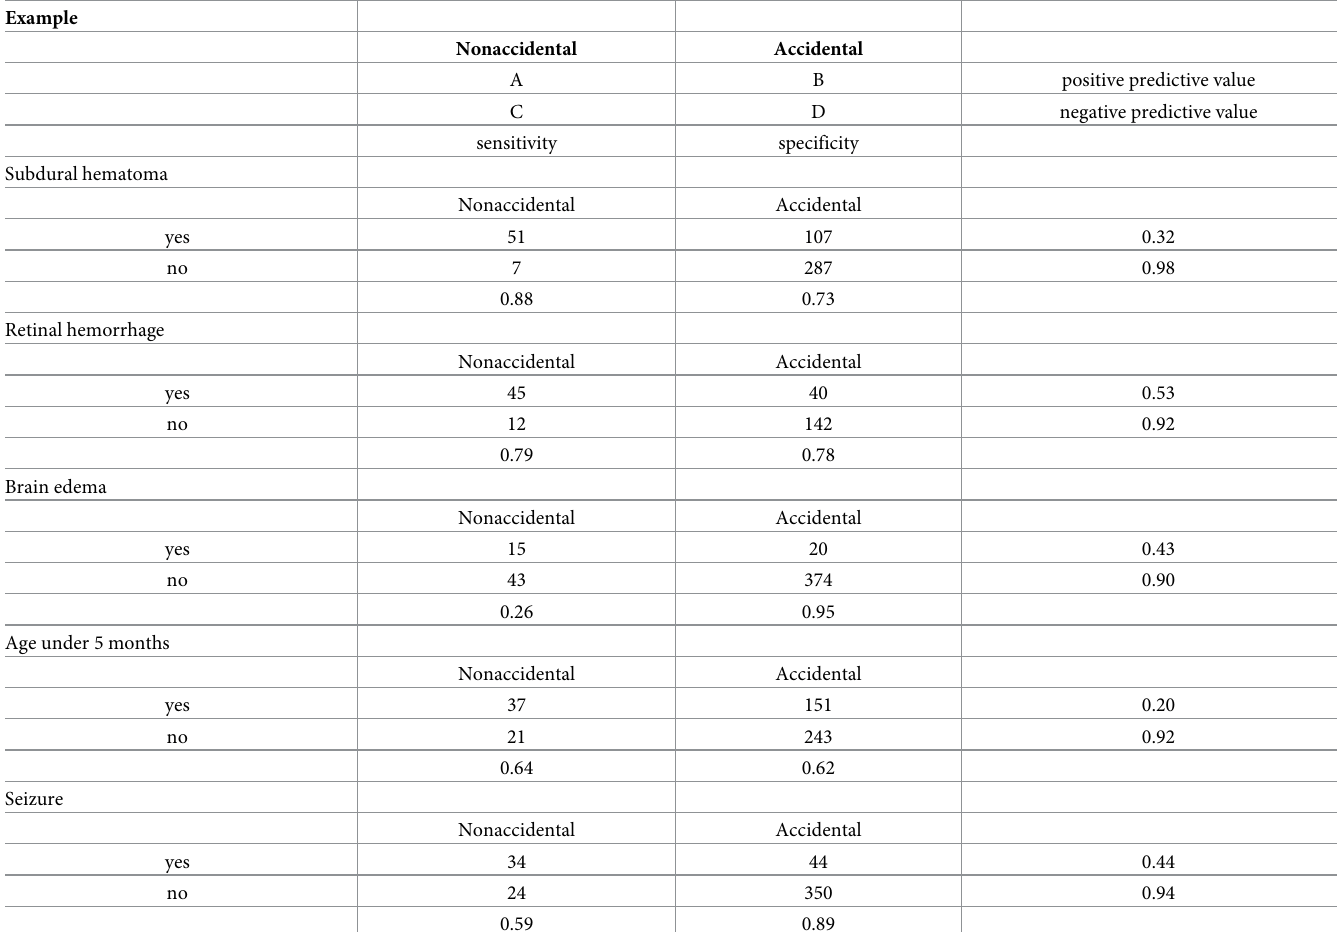
Table 7. Sensitivity, specificity, positive predictive value, and negative predictive